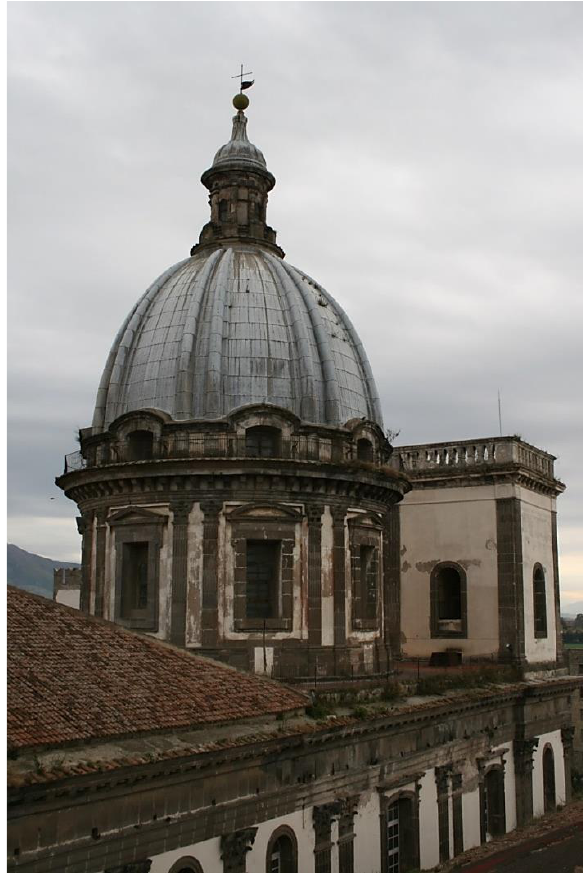
Figure 4. Capua, Annunziata Church with its massive 16th century dome.